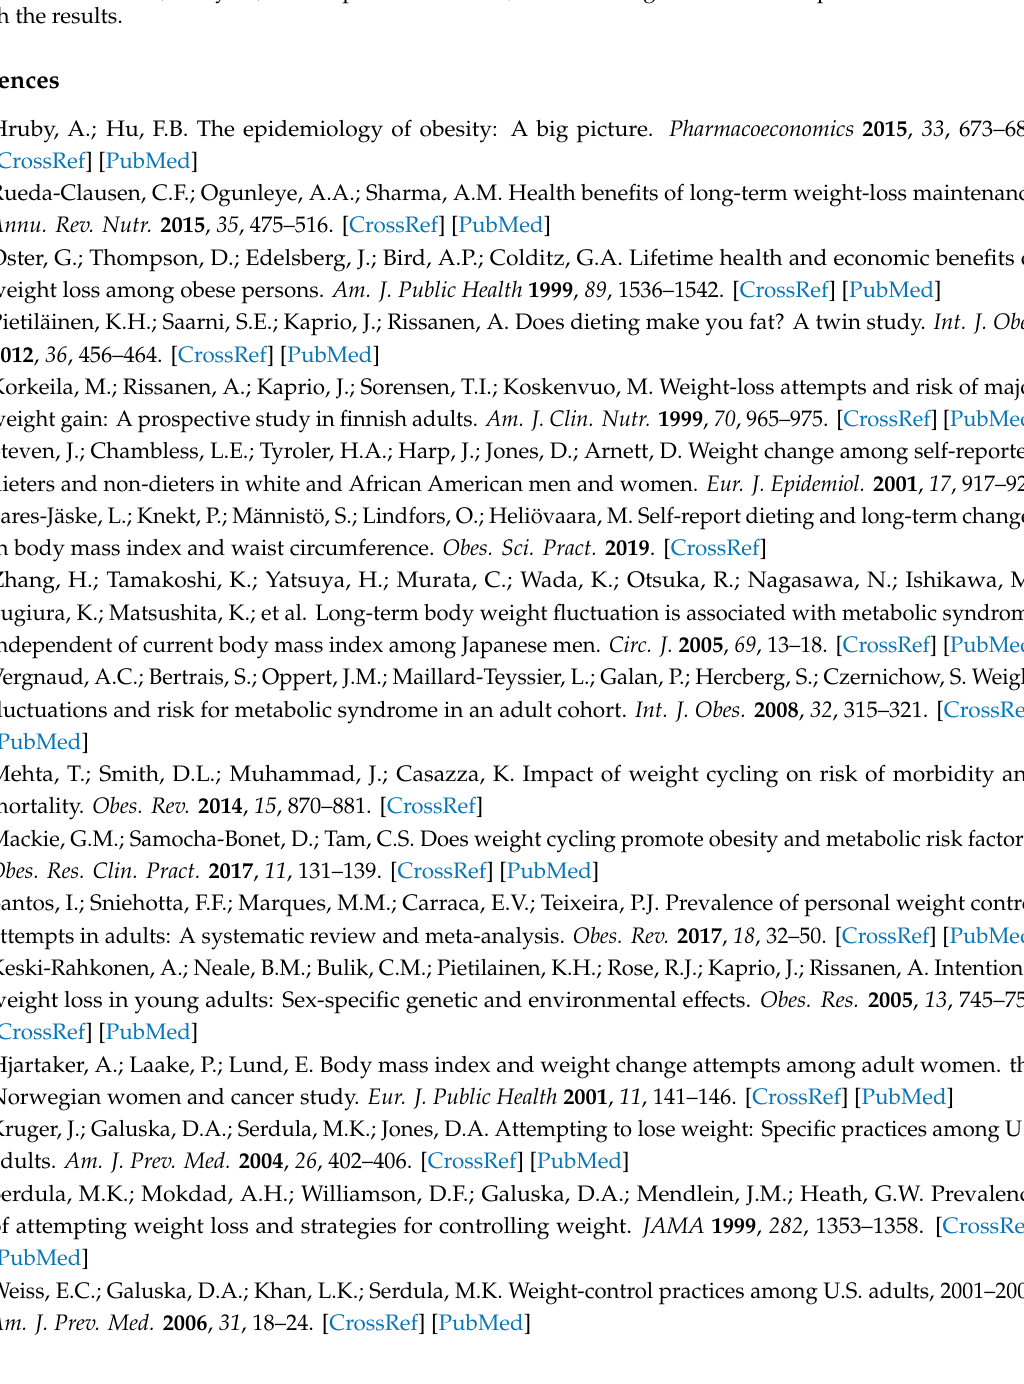
Table S1: Self-report dieting attempts and IWL during the previous year by interaction of BMI and selected